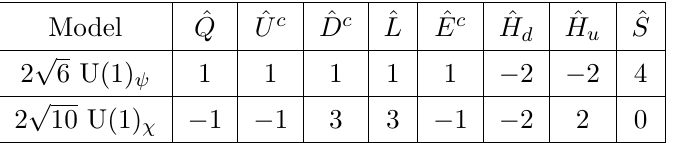
Table 1 . Charge assignments for E 6 (cid:12)elds satisfying Q i = Q (cid:31) U(1) 0 symmetry and it is instead induced by the VEV of S as (cid:22) = h v (cid:17) h S i . Employing eqs. (2.3) and (2.4), the Higgs potential can be obtained as S